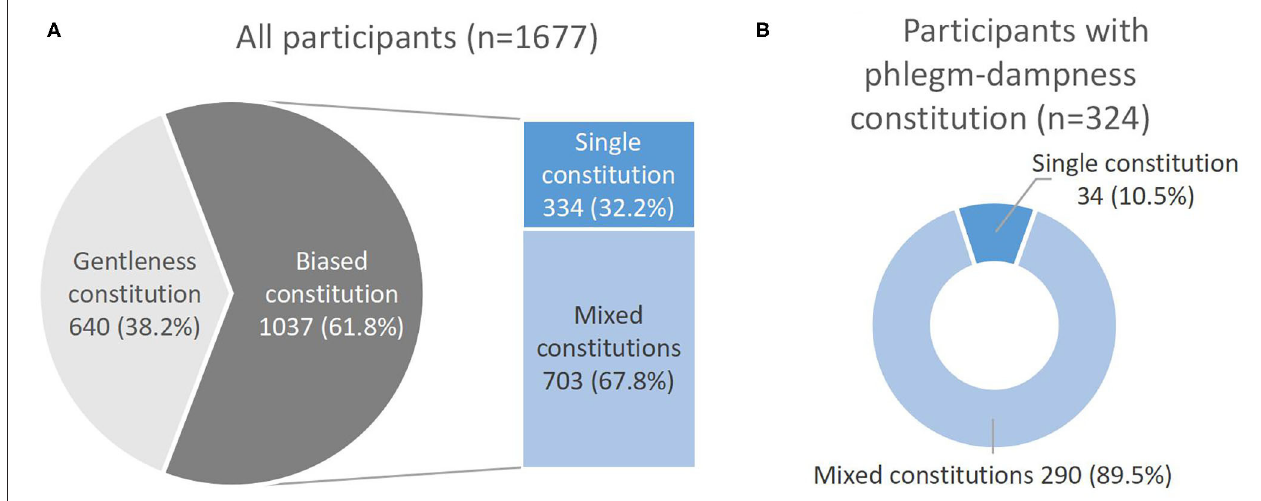
FIGURE 2 | (A) Gentleness and biased constitution distribution in 1,677 participants and the proportion of single constitution and mixed constitutions in 1,037 participants with the biased constitution. (B) The proportion of single constitution and mixed constitutions in 324 participants with the phlegm-dampness constitution.